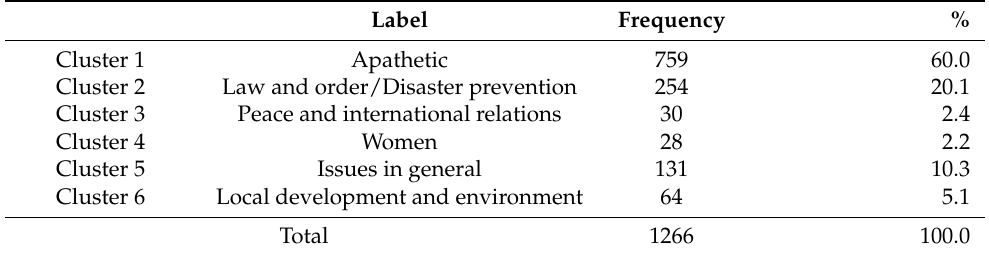
Table 5. The number of organizations in each cluster.